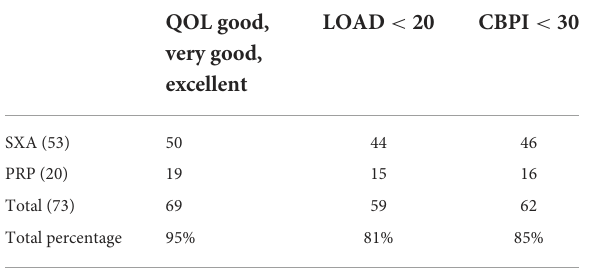
TABLE 4 Overall outcomes summary.